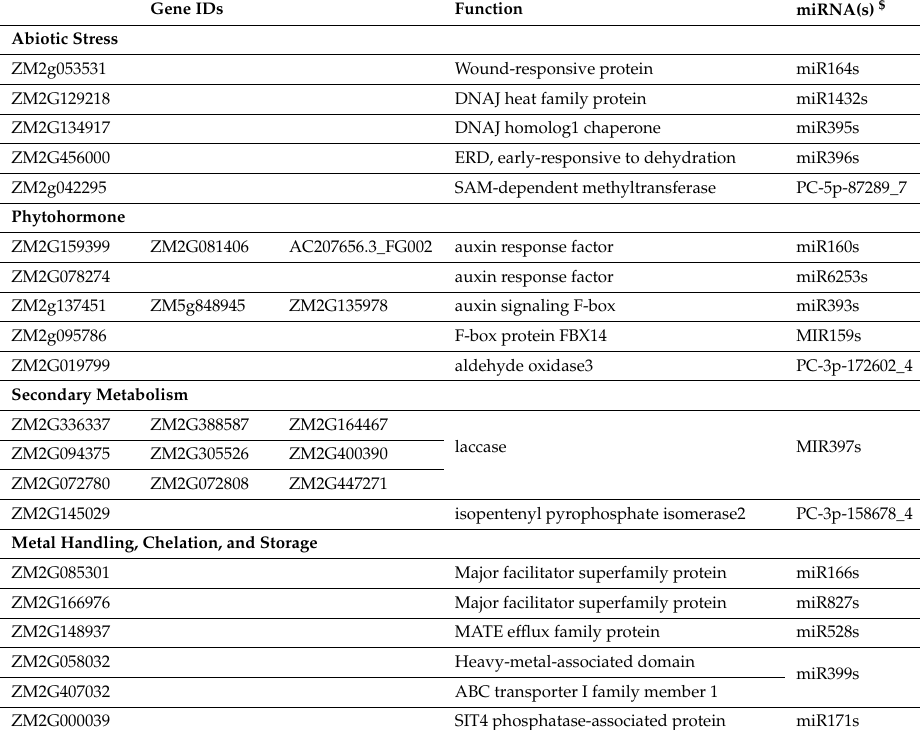
Table 3. The function classification of the predicted cleavable targets of maize xylem miRNAs. Gene IDs Function miRNA(s)